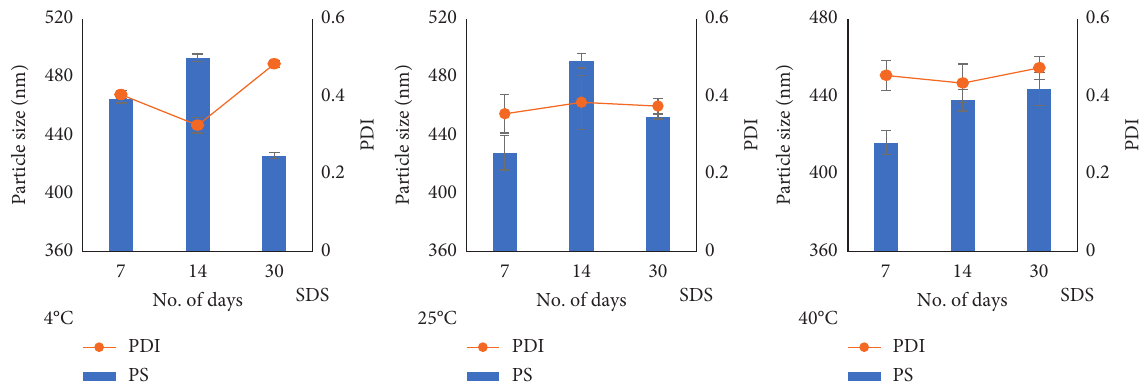
Figure 4: Stability profile of the SDS-stabilized naringenin nanosuspension as a function of number of days at different storage temperatures (after 15 homogenization cycles, pressure 1500bar and n � 3).